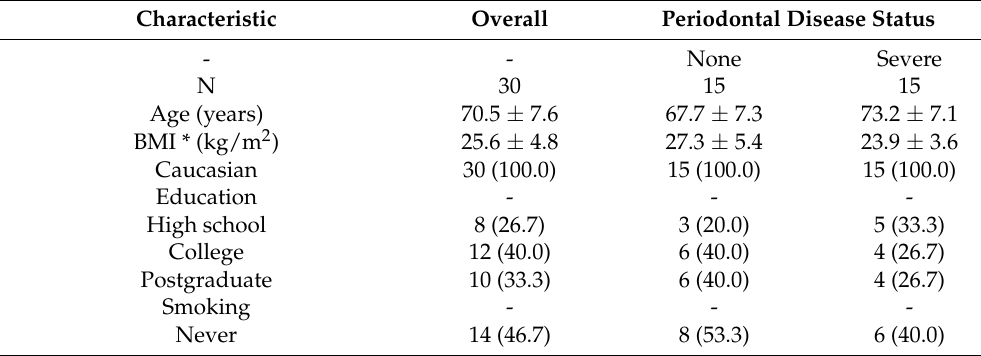
Table 1. Participant characteristics for the overall study group and according to periodontal disease status. Data are mean ± SD, or N